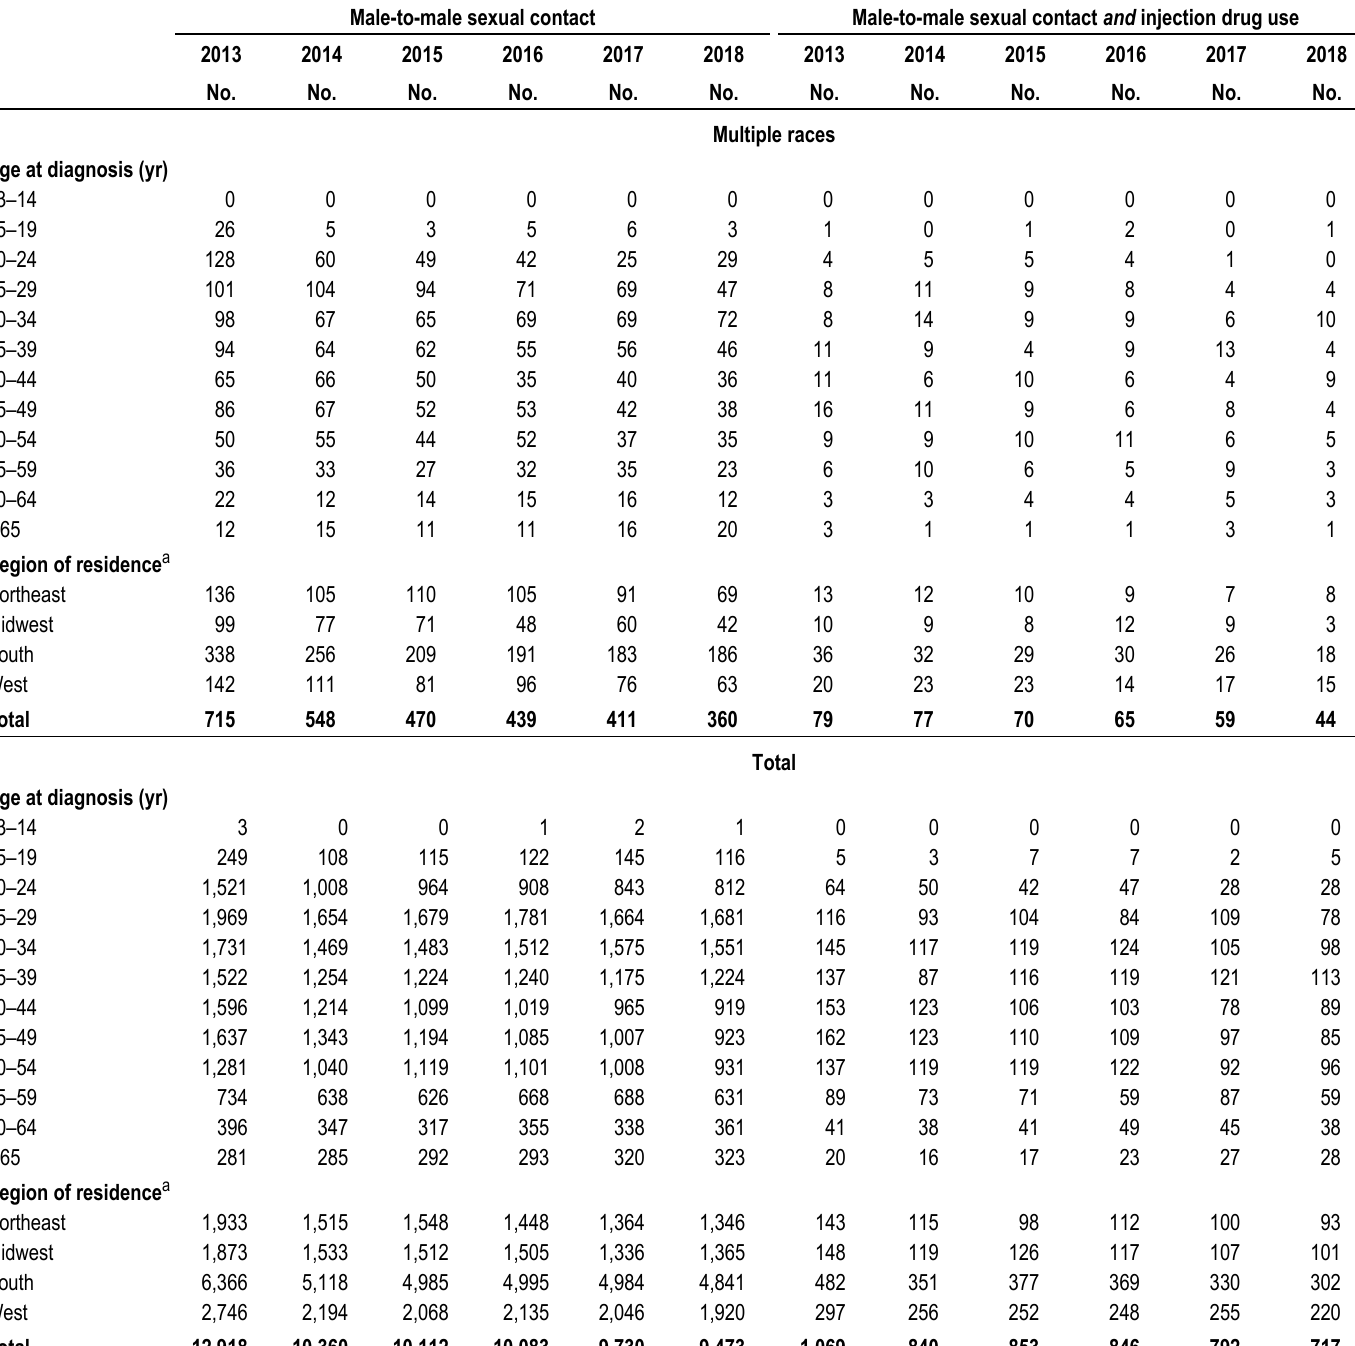
Table 10a. Stage 3 (AIDS) attributed to male-to-male sexual contact and male-to-male sexual contact and injection drug use, by selected characteristics, 2013–2018—United States (cont) Male-to-male sexual contact Male-to-male sexual contact and injection drug